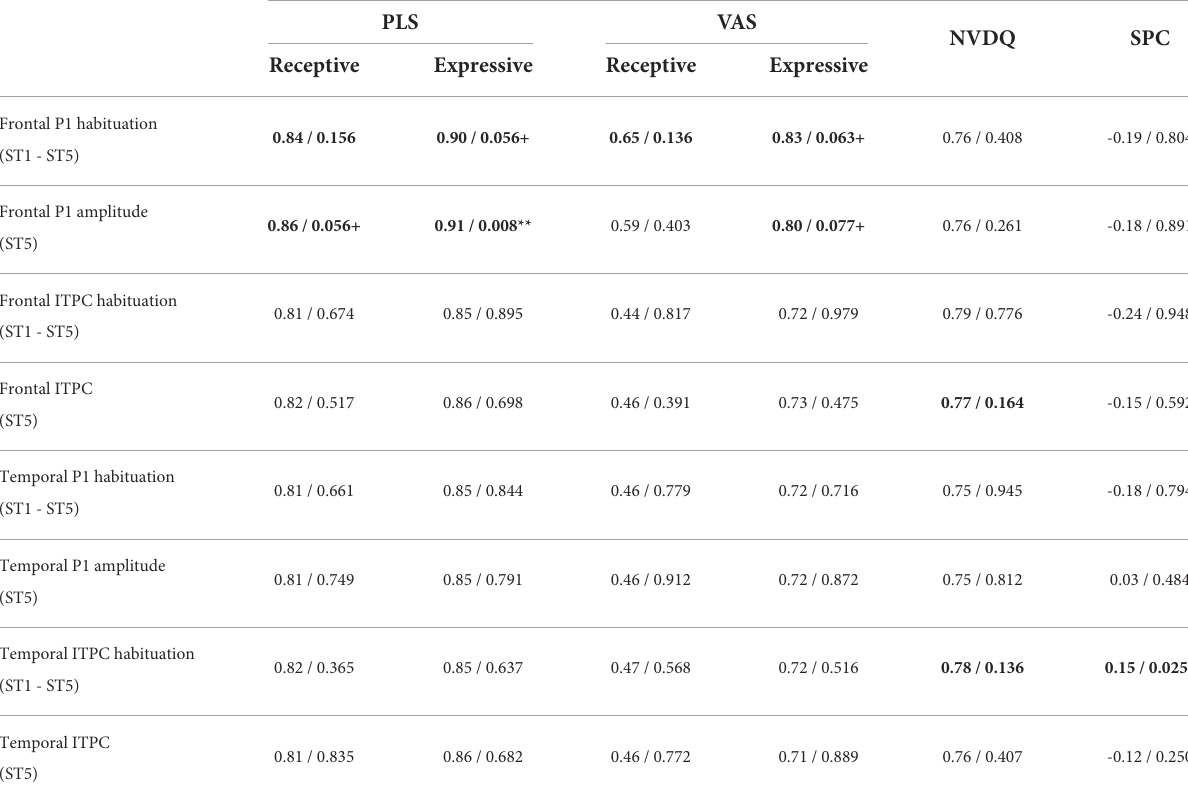
TABLE 3 Adjusted R 2 and p -values for EEG × Group interaction in Model 1.